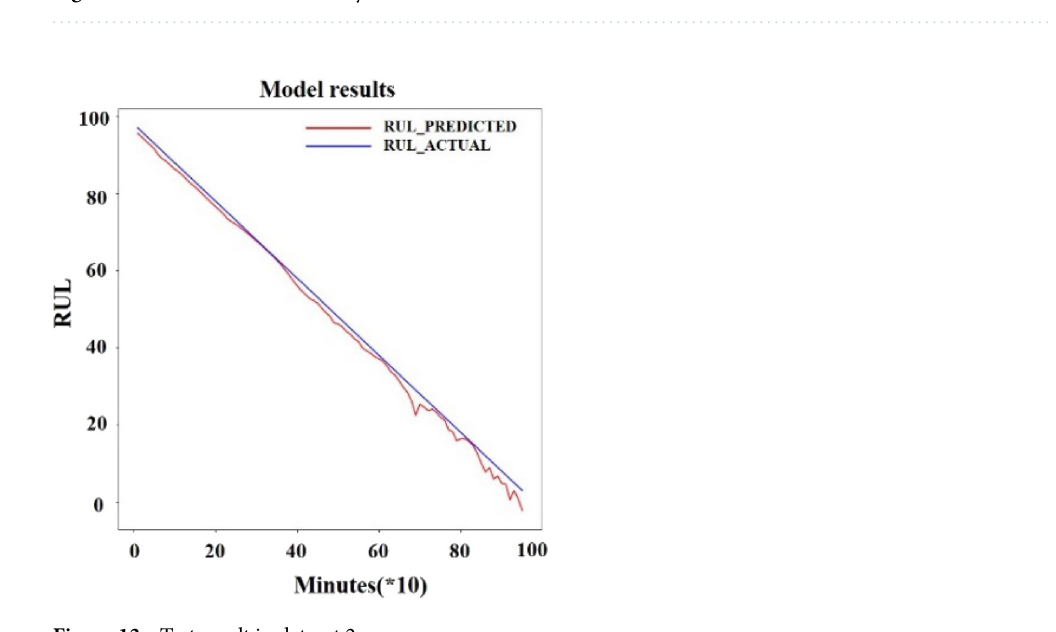
Figure 12. Result after the PSR layer.